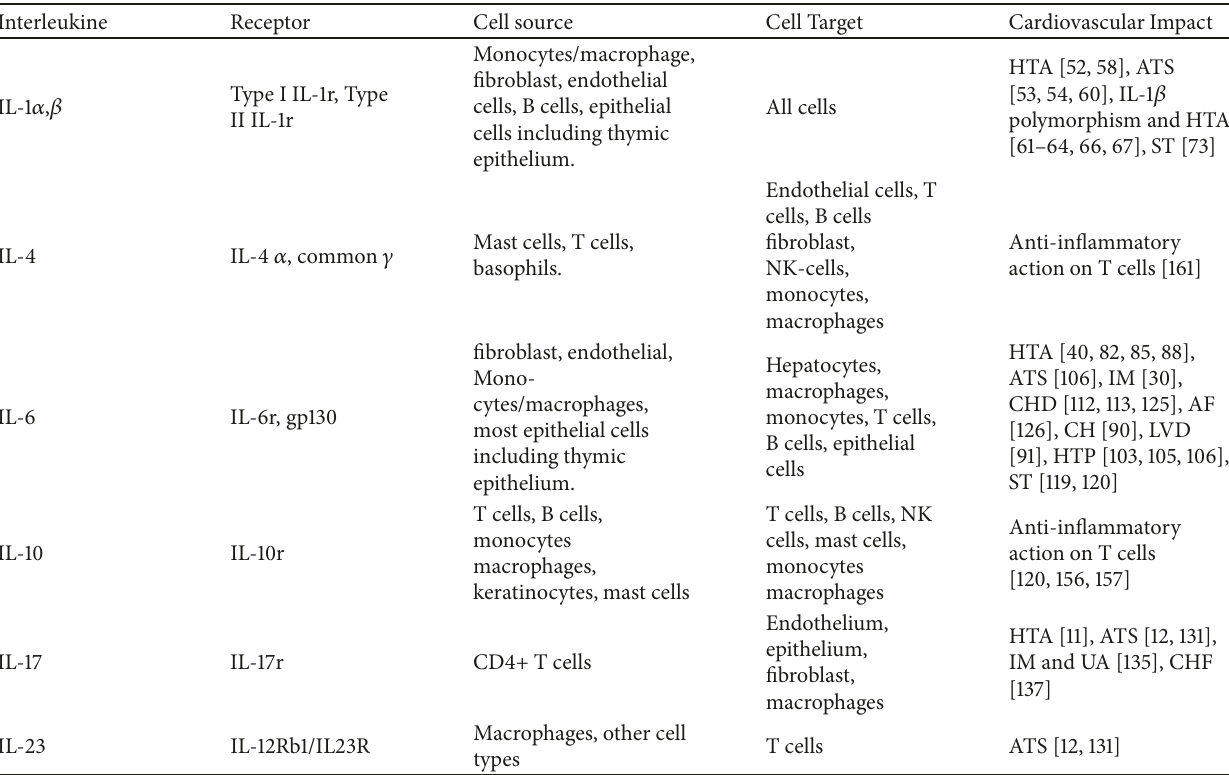
Table 1: Cytokines, cytokine receptors, and their vascular impact. HTA-arterial hypertension, ATS-atherosclerosis, ST-stroke, IM- myocardium infarction, CHD-coronary heart disease, AF-atrial fibrillation, CH-cardiac hypertrophy, LVD-left ventricule dilatation, HTP- pulmonary hypertension, UA-unstable angina, CHF-chronic heart